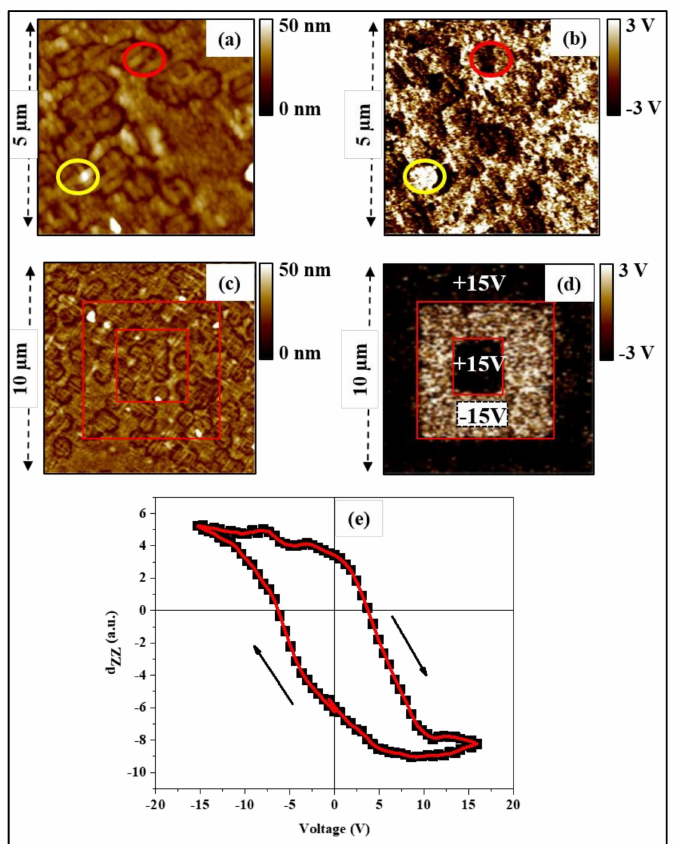
Figure 4. Microelectromechanical characterization of the TTB-Eu/BaFO heterostructure: ( a , c ) rep- resent the topography of the surface; ( b , d ) show respectively the grown out-of-plane piezoelectric response and the switching behavior of the local polarization obtained by applying a DC voltage of ± 15V. The red and yellow circles indicate two different regions with the out-of-plane polarization being oriented in opposite directions. The region circled in yellow is attributed to regions where the polarization is upward oriented while the region circled in red is associated with downward oriented polarization. ( e ) Hysteresis loop describing the variation of the longitudinal piezoelectric coefficient (d ZZ ) as a function of an applied voltage bias, confirming the ferroelectric behavior of the synthesized